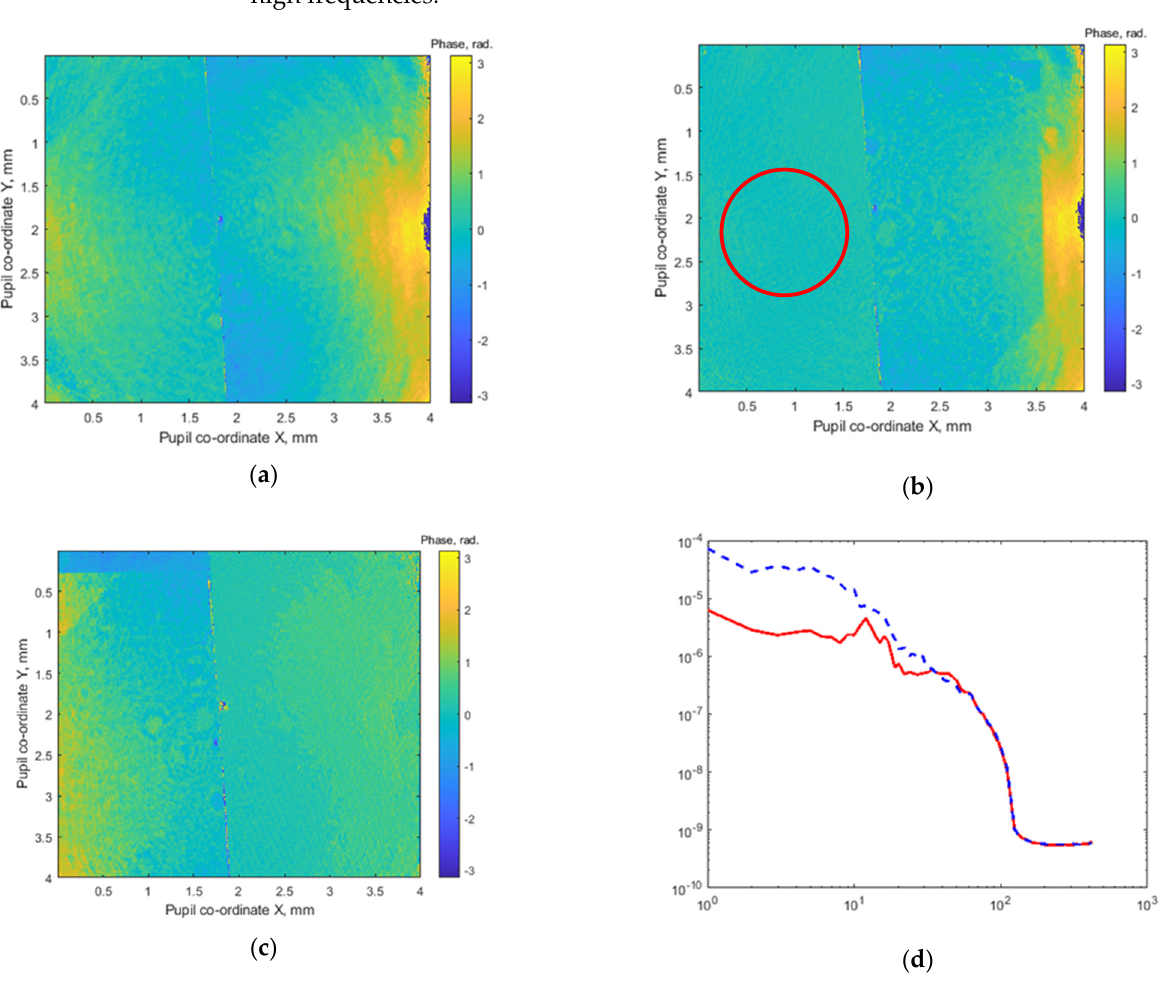
Figure 8. Correction of wavefront in left (right) semi ‐ plane in pupil: ( a )—uncorrected wavefront measured by interfero ‐ coronagraph. ( b , c )—consequently corrected wavefront in left and right semi ‐ planes (the area within the shown red circle was used as corrected pupil to form focal images in following Figure 9). ( d )—wavefront phase error power spectrum density (PSD) averaged over radial cross ‐ section; before correction—blue (dashed) line, after correction—red (solid) line.